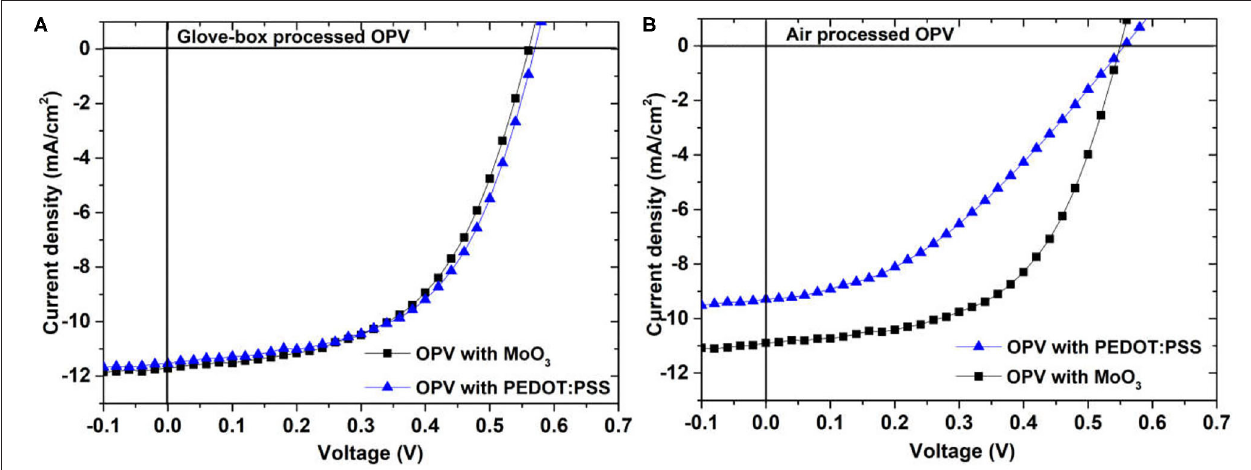
FIGURE 5 | The current density–voltage characteristics of (A) the glove-box-processed and (B) air-processed P3HT:PC 61 BM solar cells with different interfacial layer of PEDOT:PSS and MoO 3 .